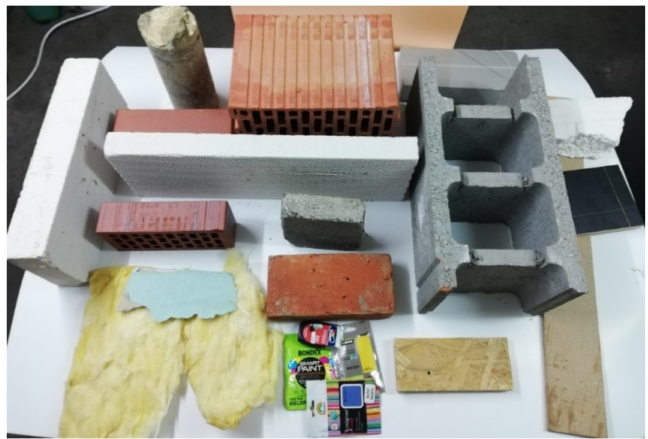
Figure 1. Examples of building materials used in the